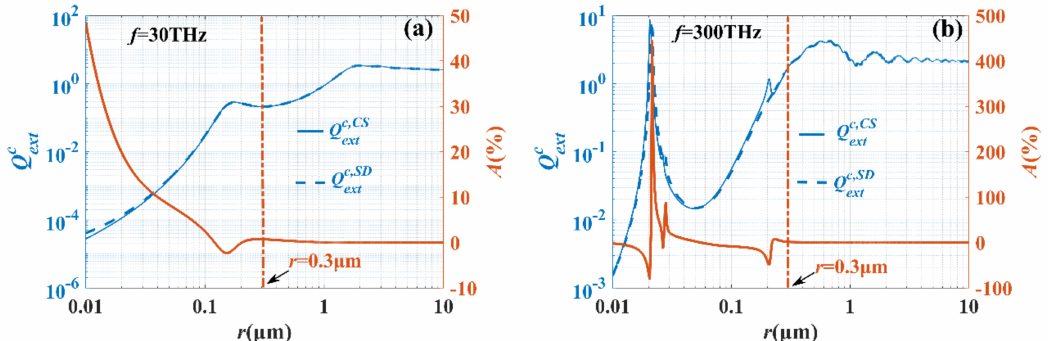
Figure 6. Difference between the surface conductivity model (dashed line) and the core-shell model (solid line) for ( a ) f = 30 THz and ( b ) f = 300